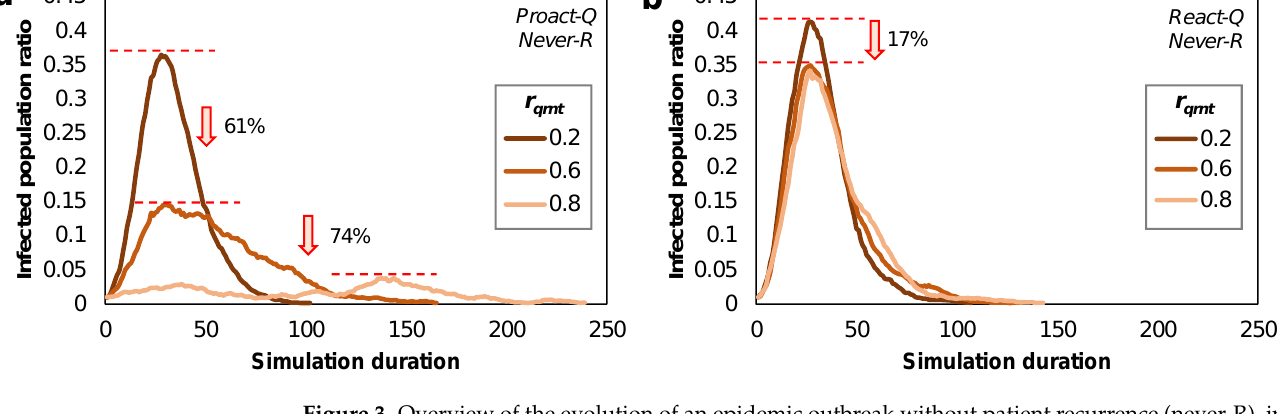
Figure 3. Overview of the evolution of an epidemic outbreak without patient recurrence (never-R), in time, measured by the infected population ratio φ ( t ) . ( a ) The proactive quarantine policy (proact-Q) is applied. ( b ) The reactive quarantine policy (react-Q) is applied. The relative drops in infected population are depicted in